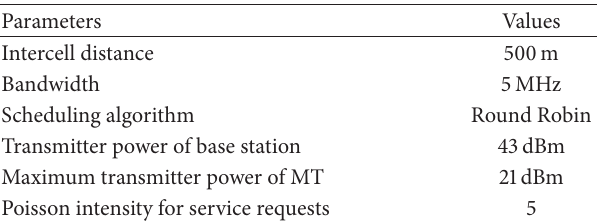
Table 3: Parameters in the simulation for state transition probabil- ities.